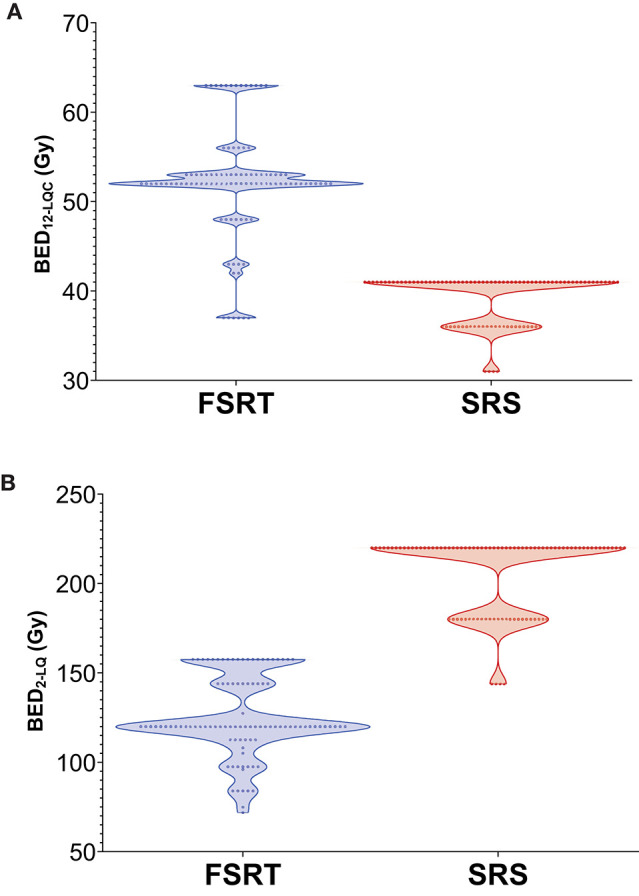
Violin Plot showing the distribution of BED12−LQC
(A) and BED2−LQ
(B) for metastases treated with FSRT and SRS, respectively. BED12−LQC = biologically effective dose for an α/β ratio of 12, linear-quadratic-cubic model. BED2−LQ = biologically effective dose for an α/β ratio of 2, linear-quadratic model.